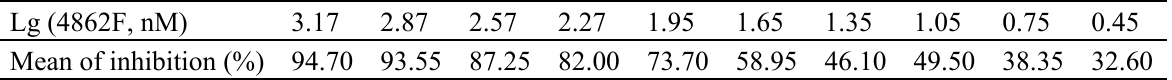
Table 3. Raw data of inhibitory activity of 4862F on HIV-1 protease. Lg (4862F,